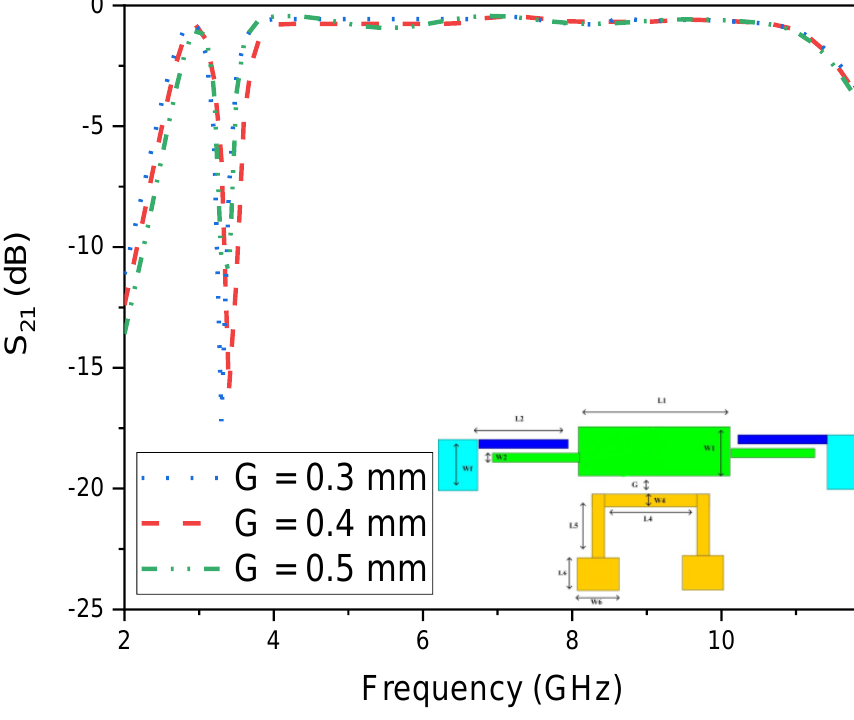
Figure 10. S 21 plot of UWB notch filter with proposed rectangular stubs.